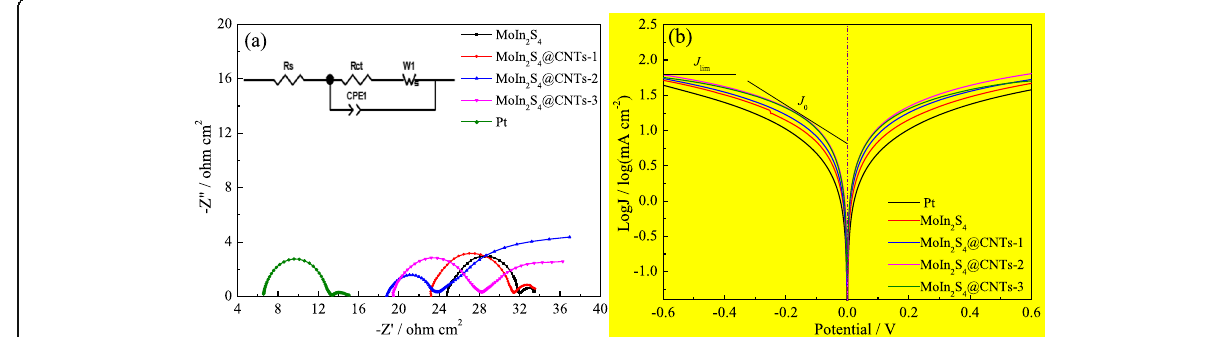
Fig. 7 a EIS and b Tafel curves of the symmetrical MoIn 2 S 4 , MoIn 2 S 4 @CNTs-1, MoIn 2 S 4 @CNTs-2, and MoIn 2 S 4 @CNTs-3 CEs